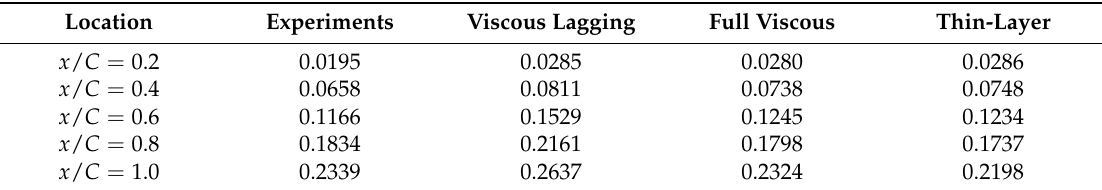
Table 2. Comparison of time-averaged non-dimensional cavity thickness with experimental results by Wang et al. [3].